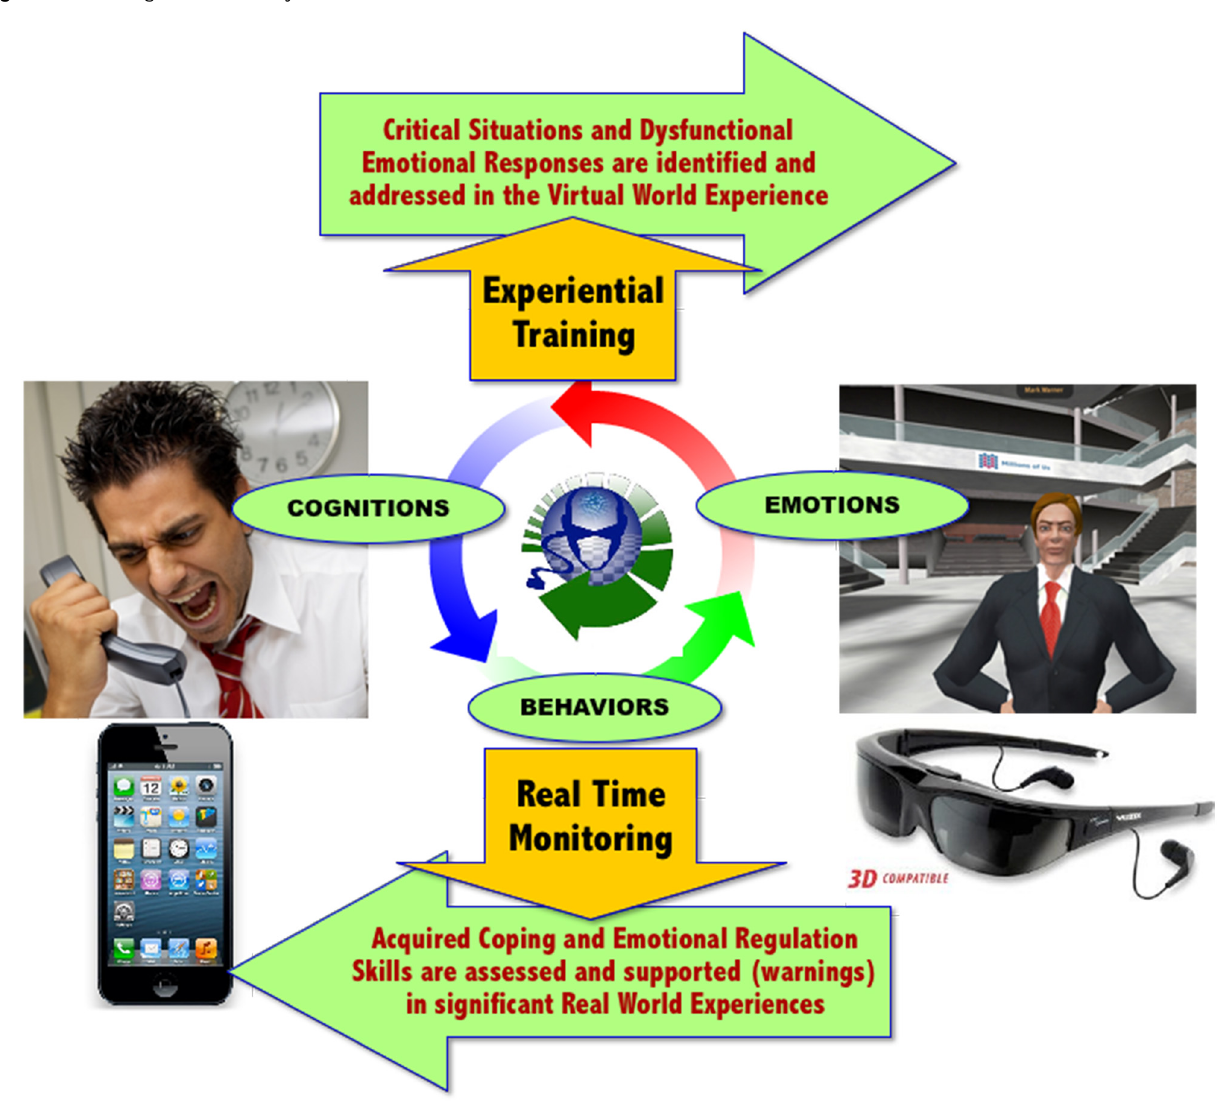
Figure 1. Advantages of